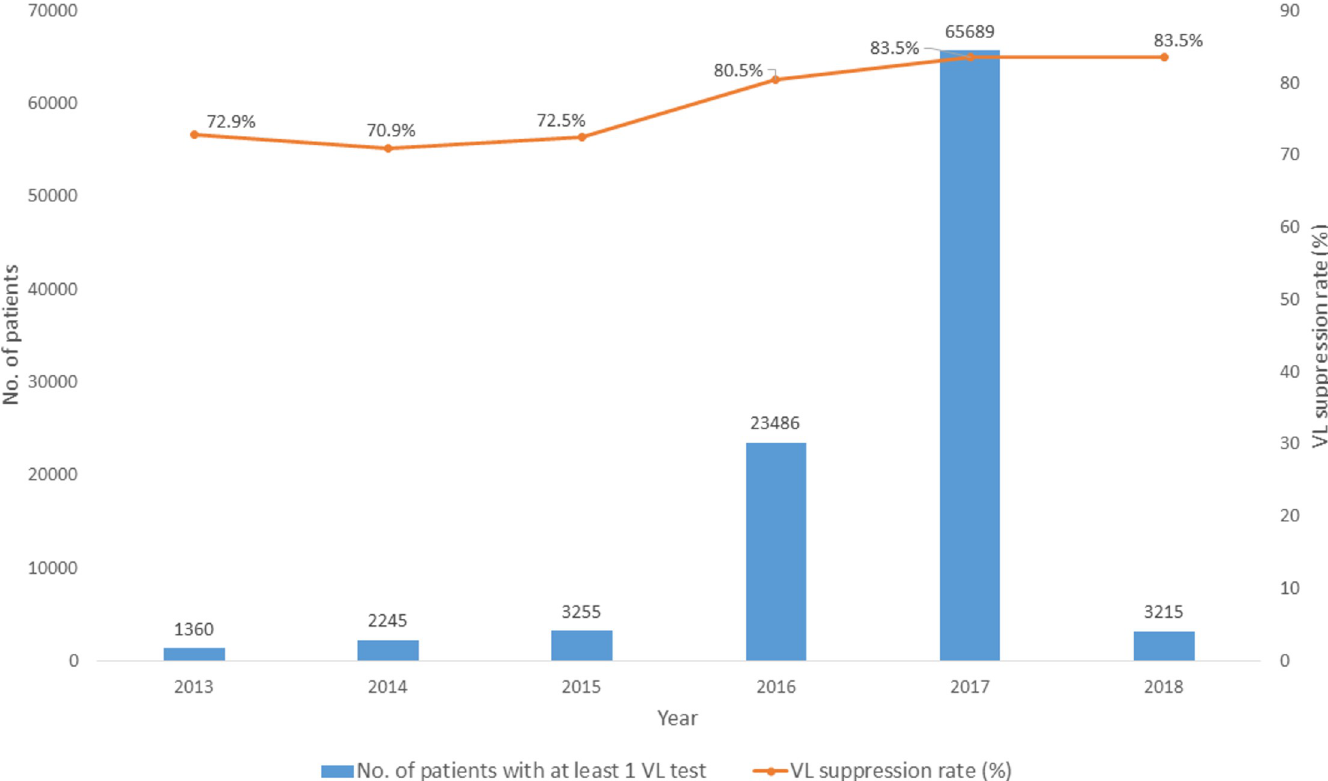
Fig 3. Number of PLHIV with at least one VL test done and proportions with viral suppression by year among those initiated ART between 2013–2017 and in care for at least 12 months at health facilities using ePMS and alive beyond 30 June 2017. VL = viral suppression; ART = antiretroviral therapy; ePMS = electronic Patient Monitoring System. NB : 652 patients with VL tests done between 2004 and 2012 out of the 99 , 902 with VL tests done between 2004 and 2018 have been excluded given the small numbers and the high probability of survival bias given that the ePMS was rolled out in January 2013 hence those who were alive among those initiated on ART before 2013 were likely entered in the system resulting in biased proportions with viral suppression